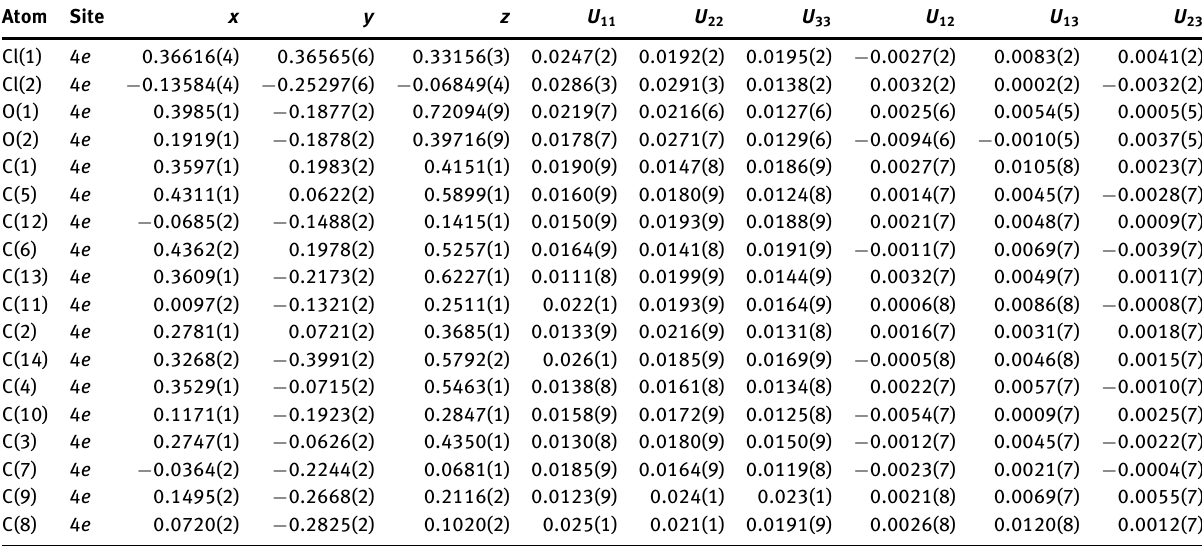
Table 3: Atomic displacement parameters (Å 2